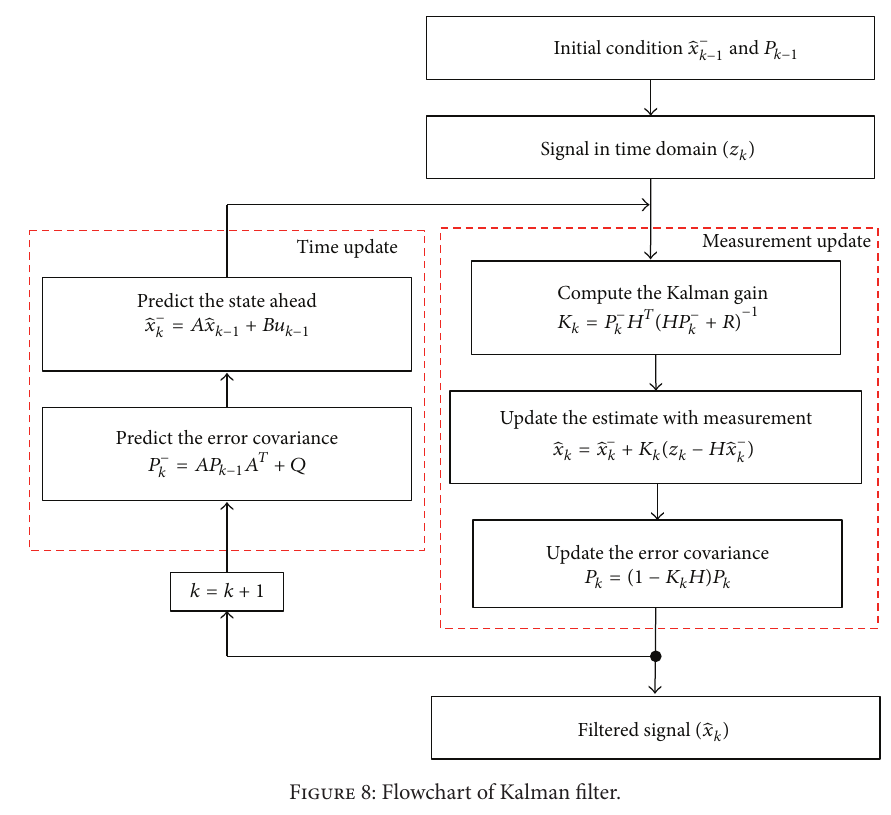
Figure 8: Flowchart of Kalman filter.